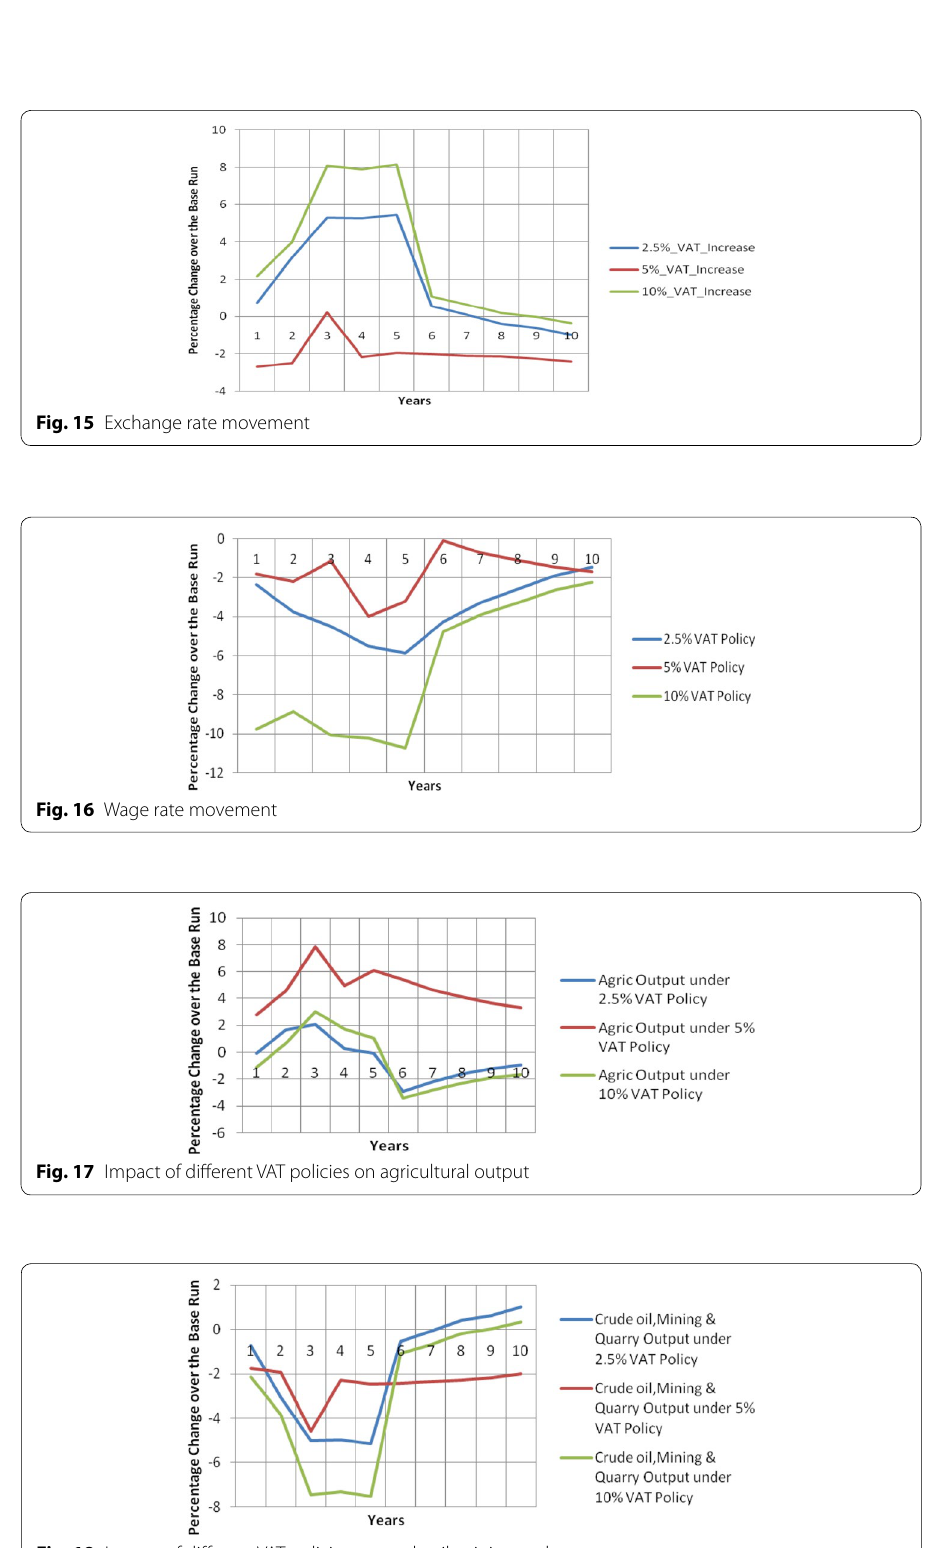
Fig. 18 Impact of different VAT policies on crude oil, mining and quarry